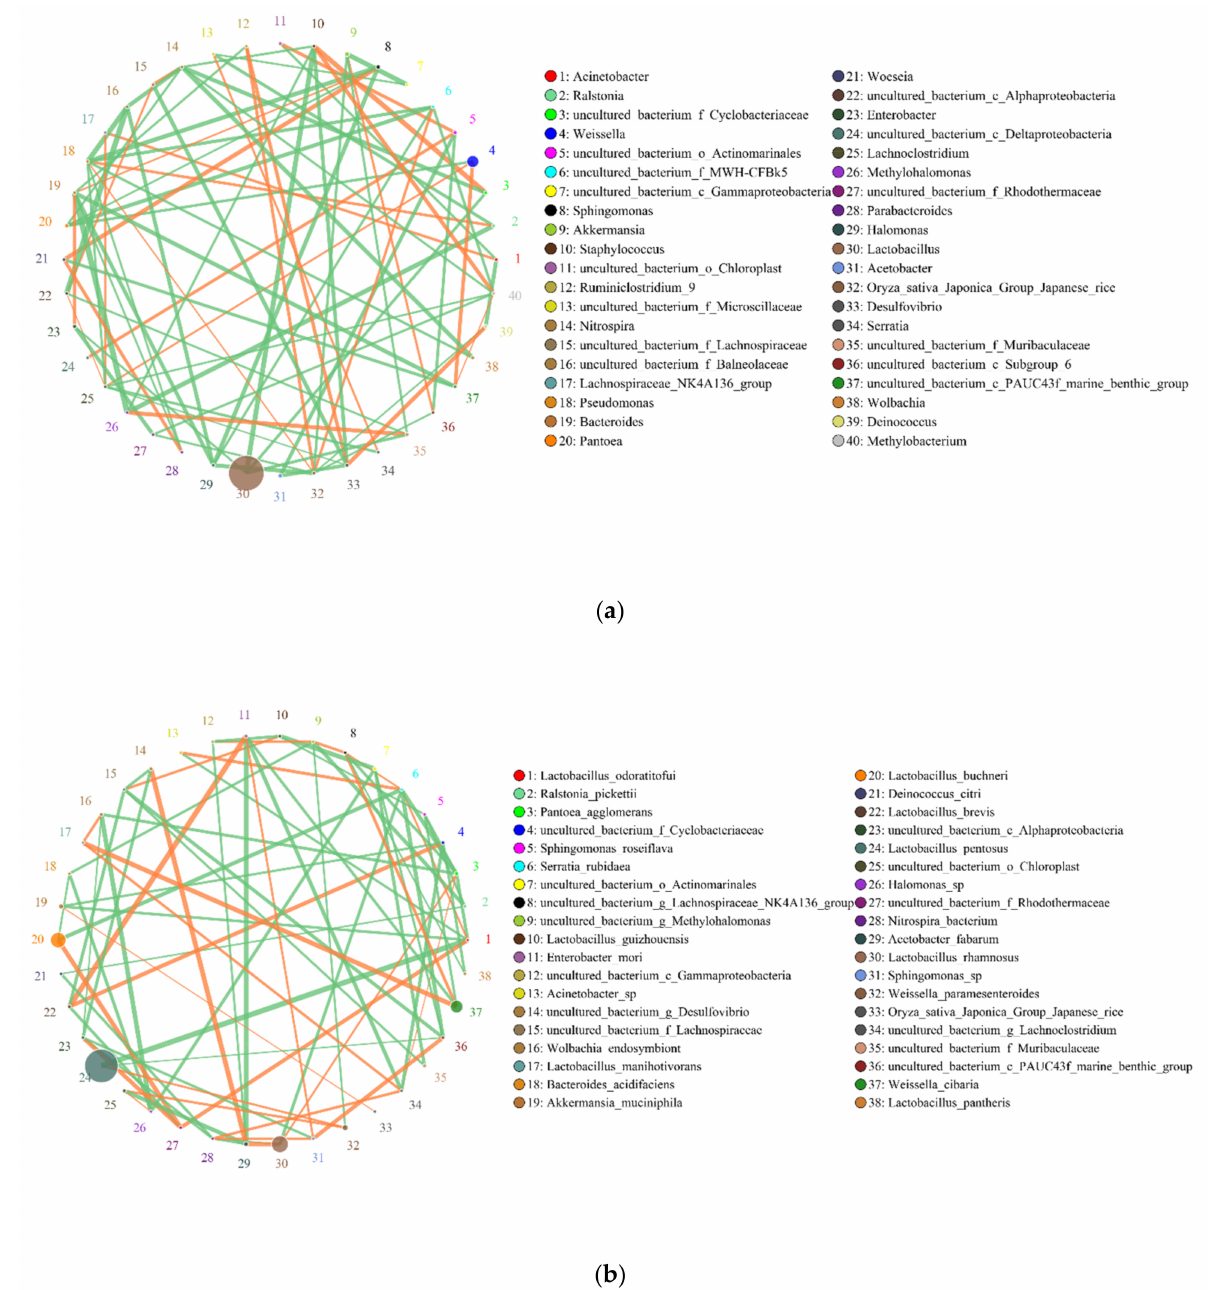
Figure 6. Spearman correlation analysis of paper mulberry silage. ( a ) In genus level; ( b ) in species